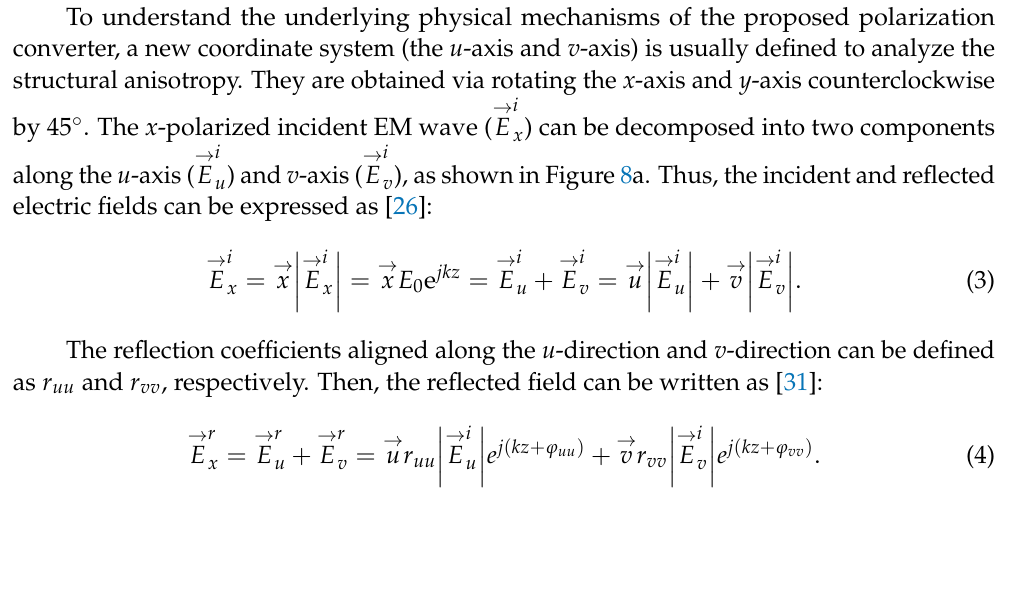
Figure 7. The PCRs for normal x -polarization incidence. ( a ) θ = 10 ◦ ; ( b ) θ = 20 ◦ ; ( c ) θ = 30 ◦ ; ( d ) θ = 40 ◦